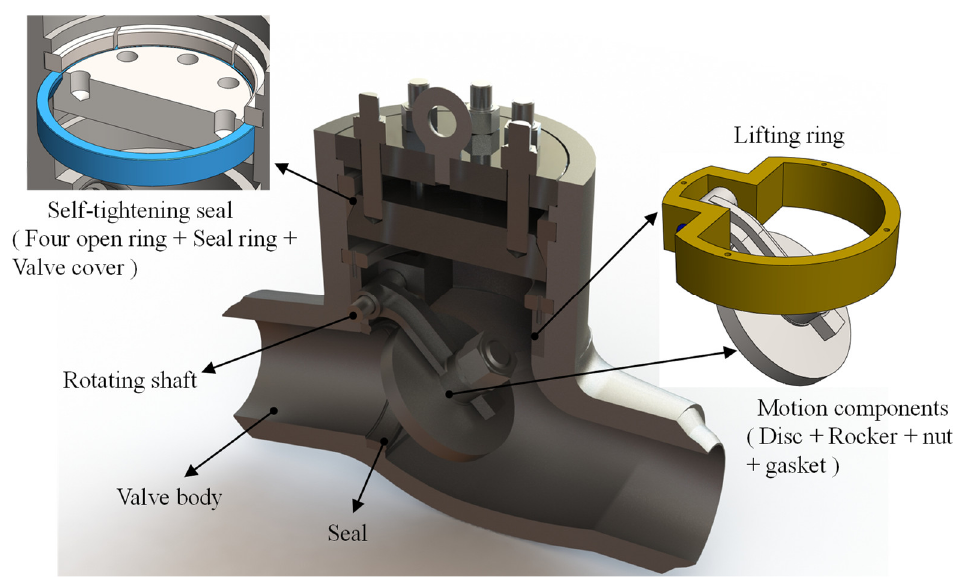
Figure 2. Structure of molten salt swing check valve.